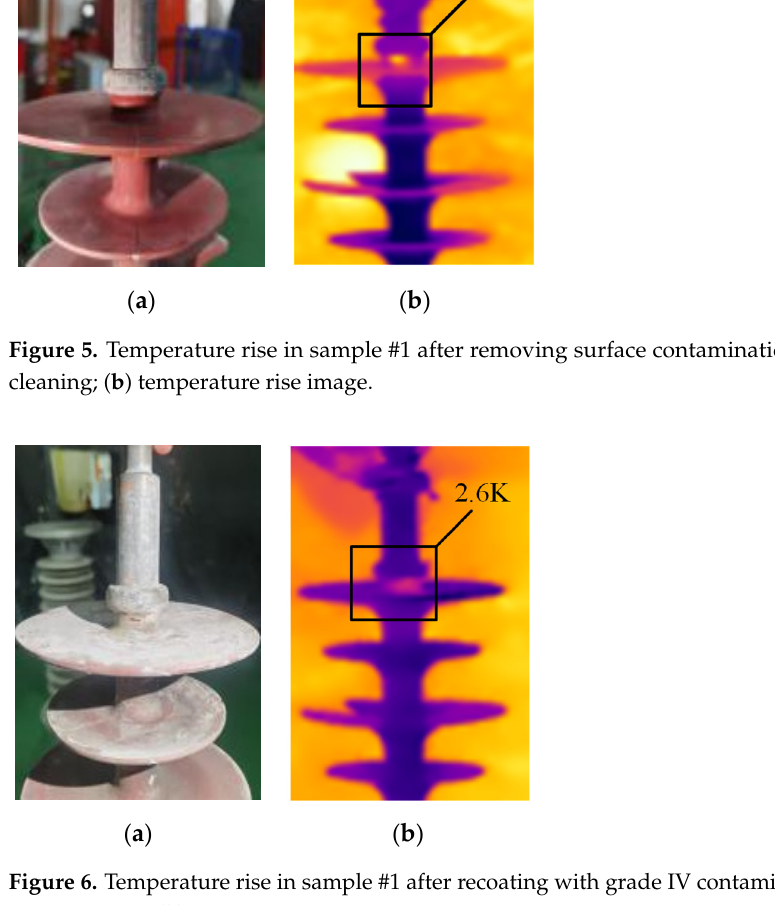
Figure 6. Temperature rise in sample #1 after recoating with grade IV contamination: ( a ) contami- nation recoating; ( b ) temperature rise image.